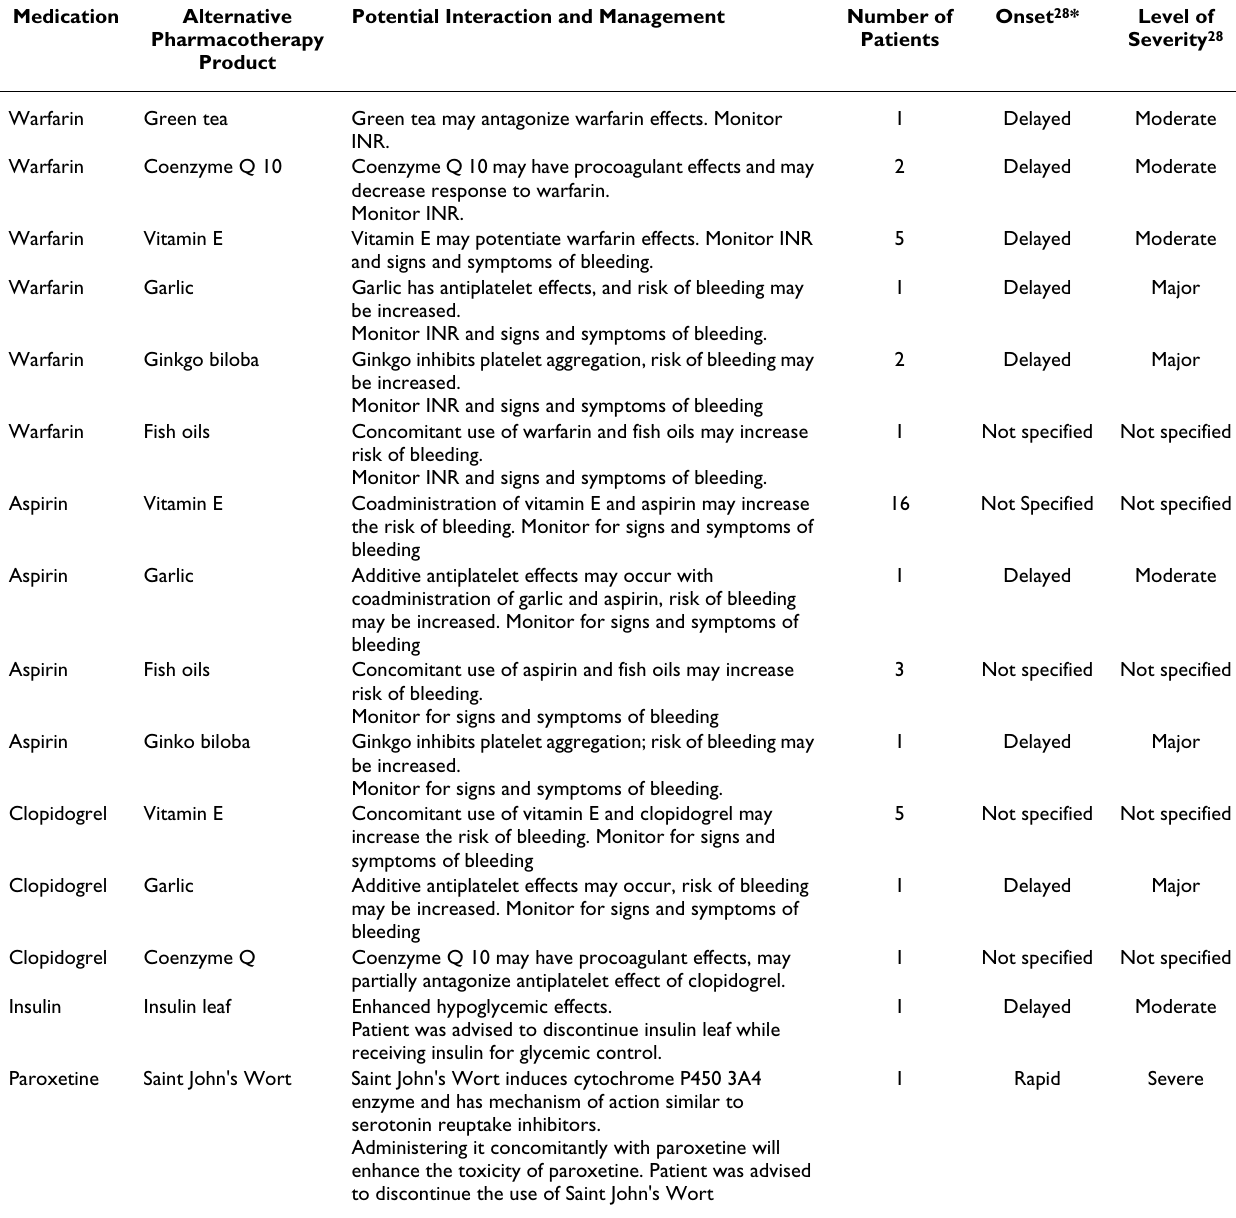
Table 4: Potential Drug-Biological Based Therapies Interactions & Management Medication Alternative Potential Interaction and Management Pharmacotherapy Product Warfarin Green tea Green tea may antagonize warfarin effects. Monitor INR. Warfarin Coenzyme Q 10